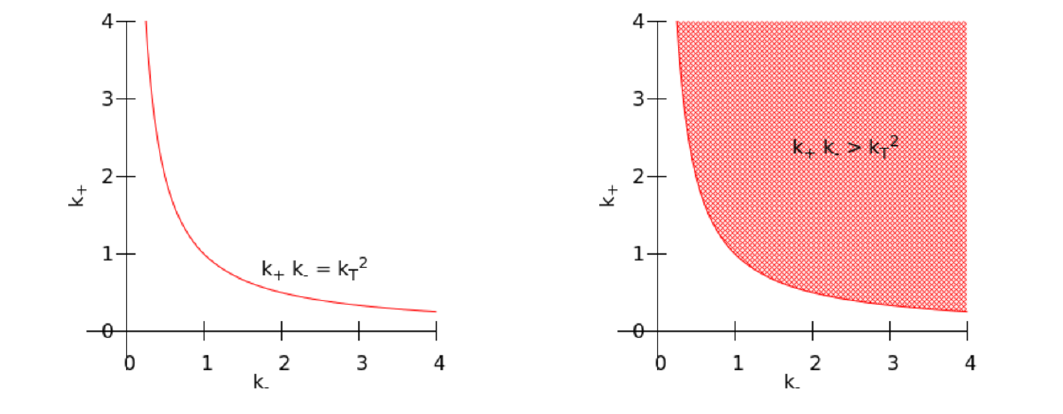
Figure 3 . Integration regions over the light-cone components of the on-shell (left) and o(cid:11)-shell gluon. The former corresponds to the integrals of the NLO soft function de(cid:12)ned in section 3, the latter to bubble integrals of the NNLO soft function discussed in section